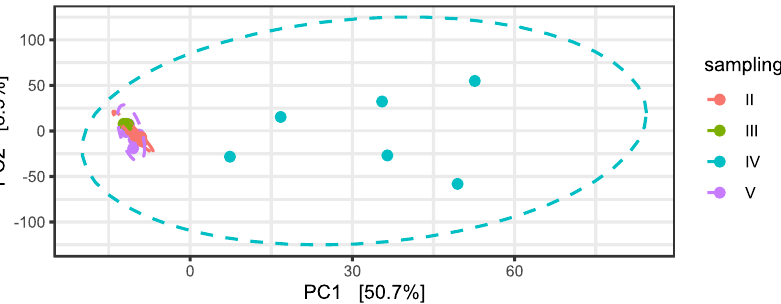
Figure 4. Principal Component Analysis (PCA) on centered log-ratio transformed counts at ASV level and variance percentage explained by each component. Ellipses show the Normal-theory confidence regions with alpha = 0.95. Permeate samples are colored in relation to the time of sampling. Differences in permeate taxonomic composition are present in relation to 197 ASVs with statistically different abundance when considering sampling timepoint (Table S6).